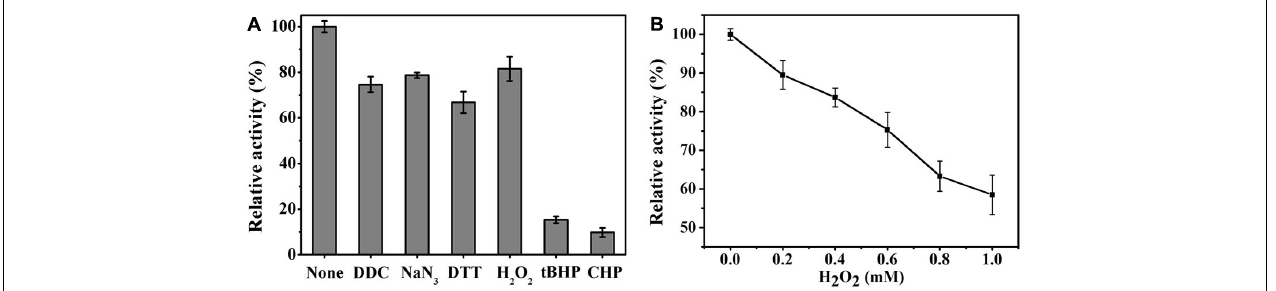
FIGURE 8 | (A) The effect of chemicals on Ps-Grx3 activity. Inhibition profiles of Ps-Grx3 after treatment with 0.5 mM DDC, NaN 3 , DTT, H 2 O 2 , tBHP, and CHP. Relative Ps-Grx3 activity was estimated by considering the activity without chemicals-point as 100%. (B) Inactivation of Ps-Grx3 by H 2 O 2 . Ps-Grx3 was treated